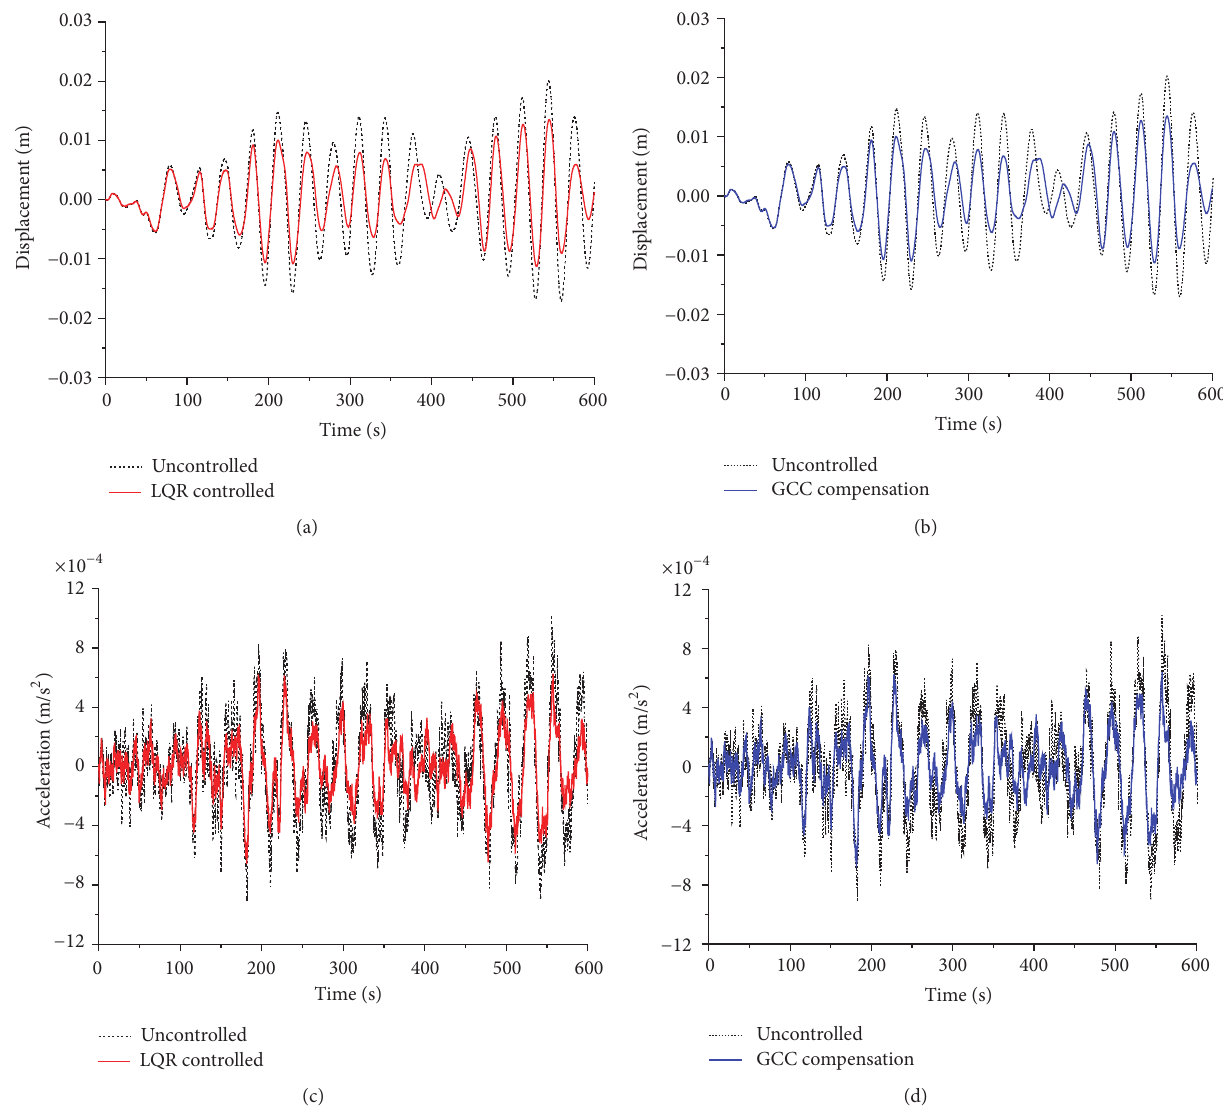
Figure 5: Comparison of structural responses to 8th floor. (a) and (c) Under uncontrolled and controlled by LQR algorithm without time- delay. (b) and (d) Under uncontrolled and controlled with GCC compensation.